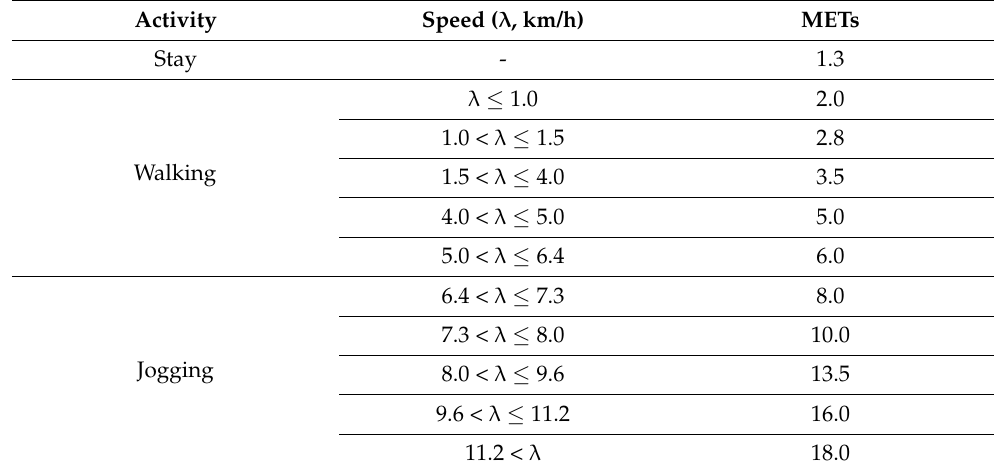
Table 1. Metabolic equivalent.